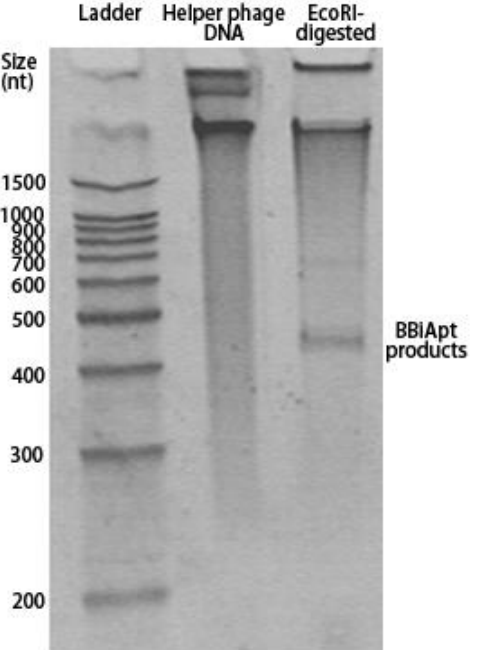
Figure 2. Digestion of the amplified phagemid DNA-released BBiApt products. Lane 1 : 1500bp ladder; Lane 2 : Phagemid DNA; Lane 3 : Digested phagemid DNA. The BBiApt products band could be